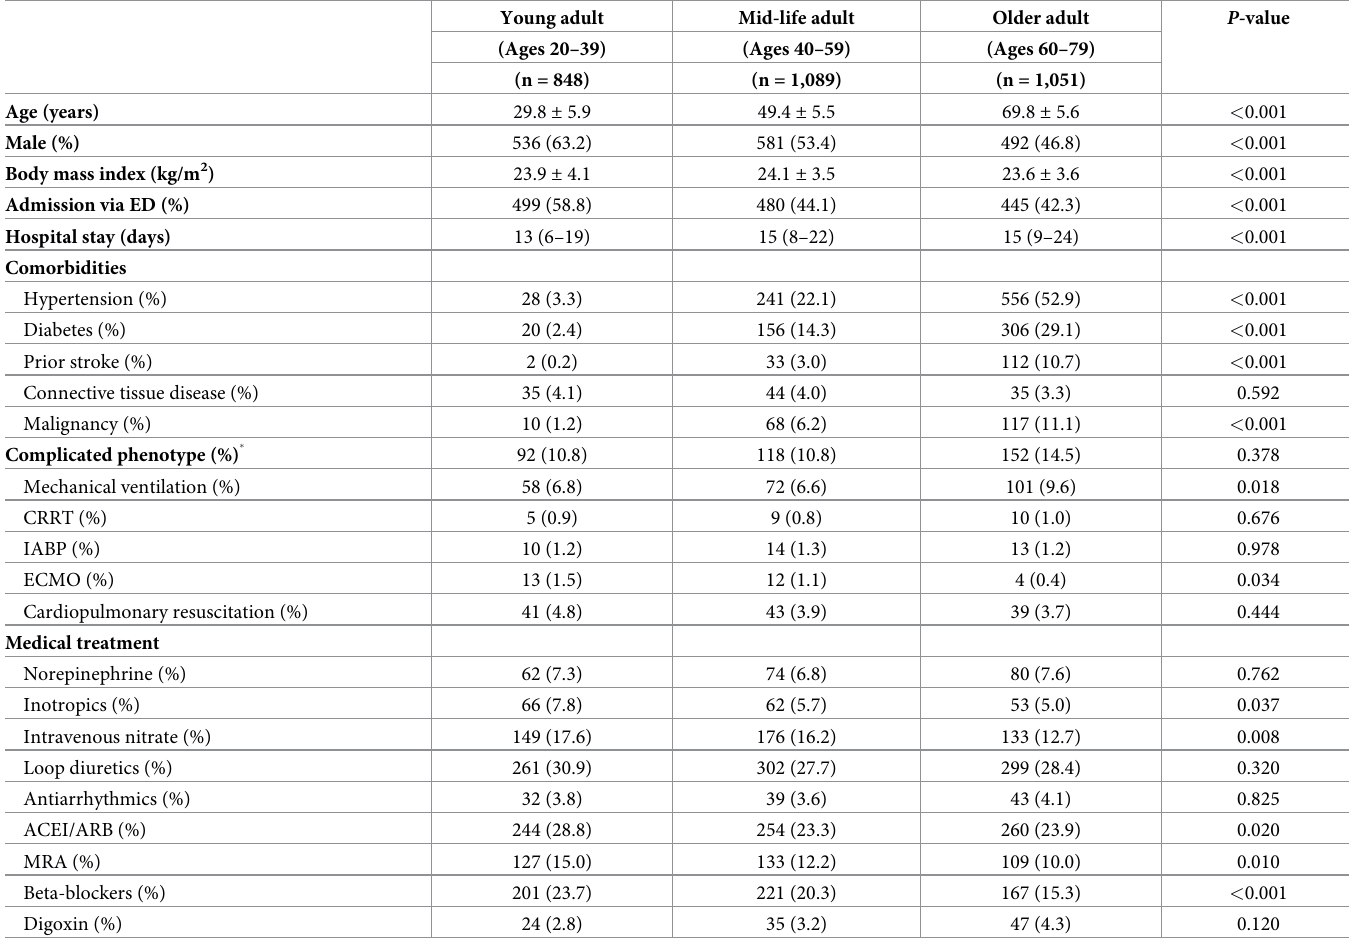
Table 1. Baseline